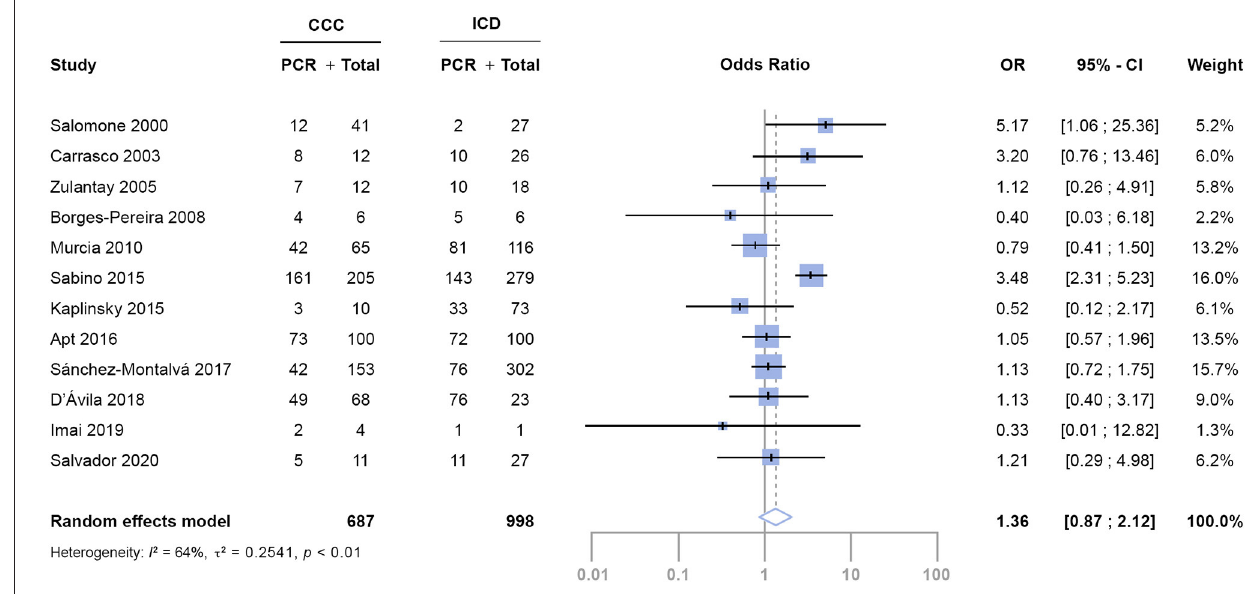
FIGURE 2 | Evaluation of the association between PCR detection between patients with CCC and ICD. CI, confidence interval; OR, odds ratio.